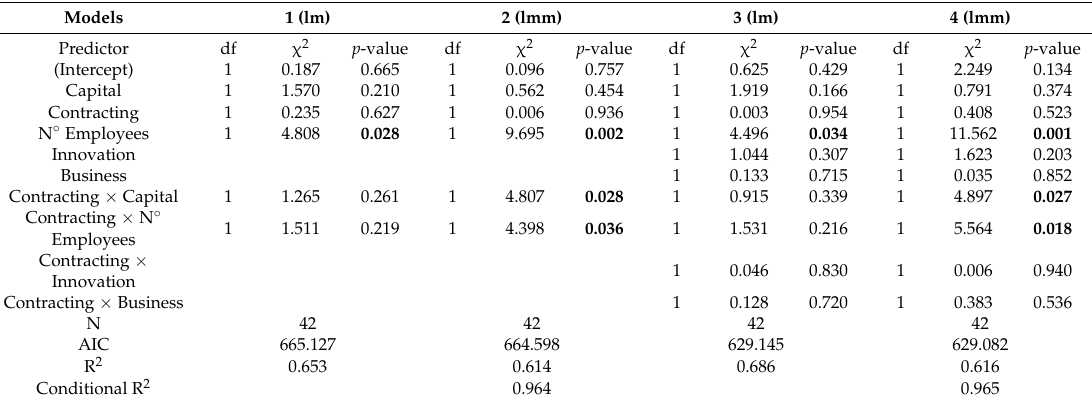
Table 4. Results of the linear and mixed linear effect models for growth in production (t/month) in the period five to ten years.